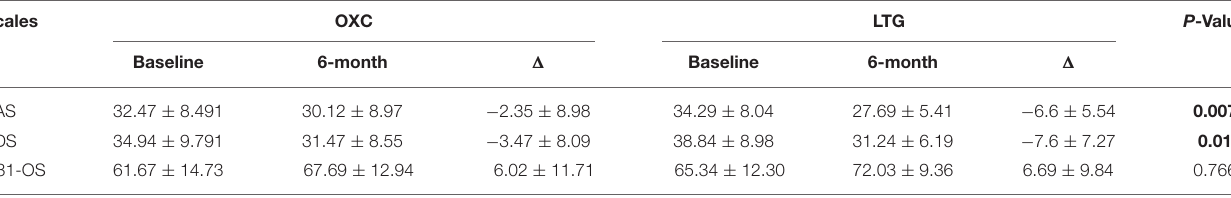
OXC, oxcarbazepine; LTG, lamotrigine; 1 , scores change at 6-month follow-up compared with baseline; SAS, self-rating anxiety scale; SDS, self-rating depression scale; OS, overall score; Q31, QOLIE-31. Bold Value indicates the p <